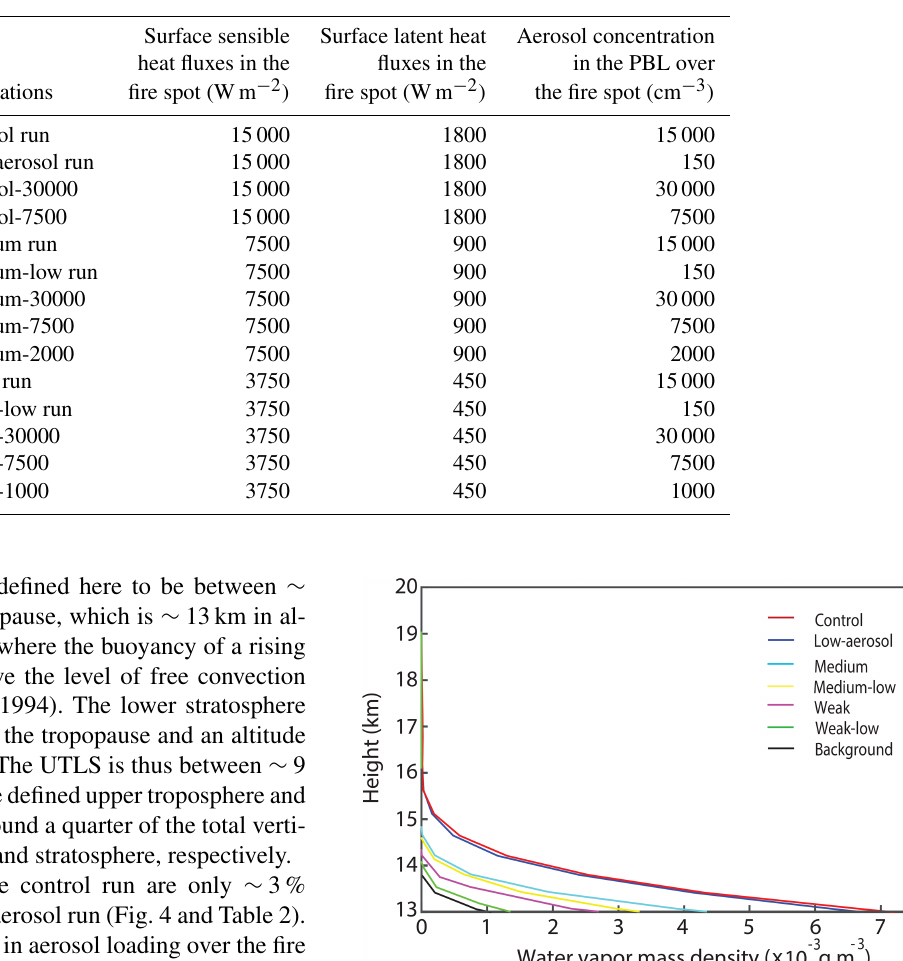
Table 1. Summary of simulations.